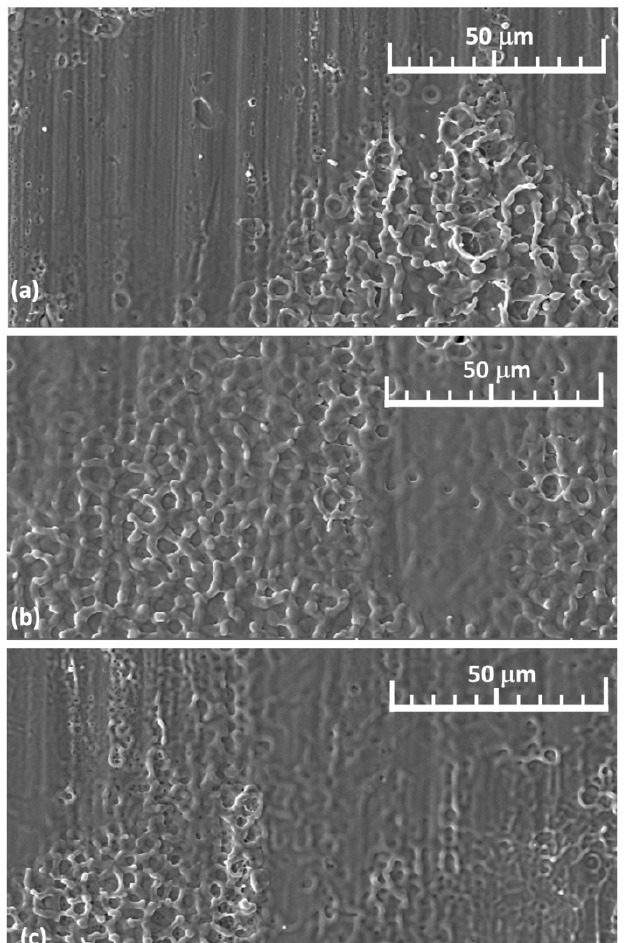
Figure A1. SEM micrographs for one-beam laser processed Cu specimens using the spot-by-spot method with a 5 mm spot size for number of pulses per spot of: ( a ) 2, ( b ) 4, and ( c ) 6.